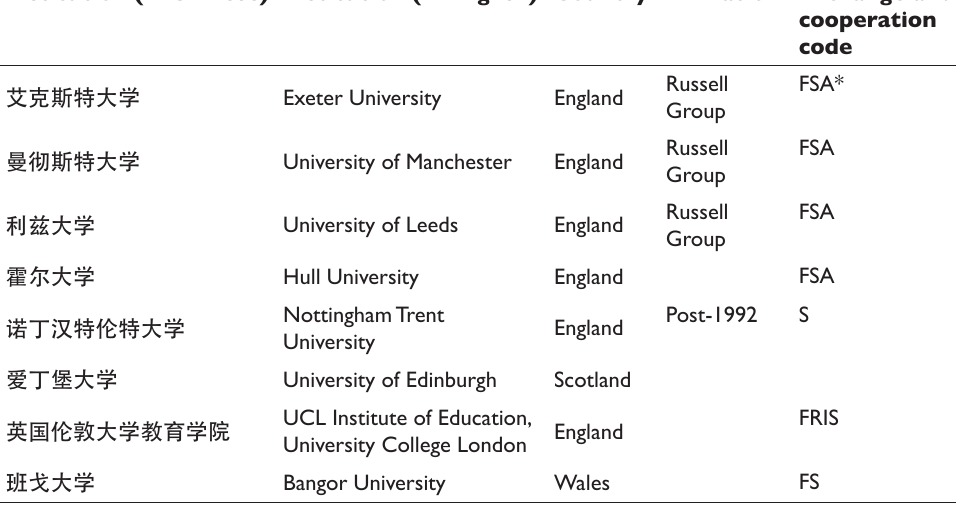
Table 4: EastChinaNormalUniversity’spartnerinstitutionsintheUK Institution (in Chinese) Institution (in English) Country Affiliation Exchange and